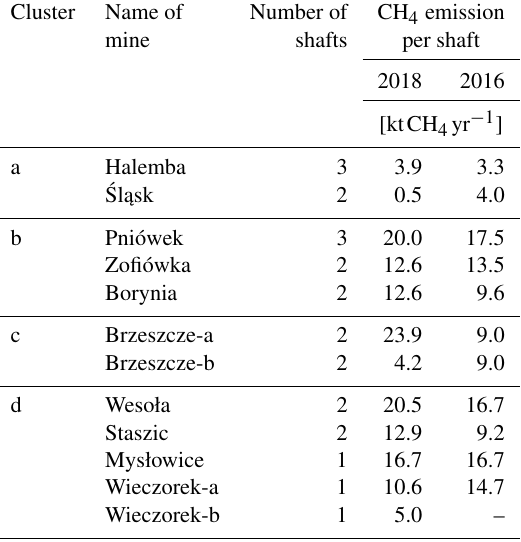
Table 1. Investigated coal mines and their annual CH 4 emissions based on the CoMet ED v4 inventory for the year 2018. The values for 2016 are only listed for comparison. The locations of clusters are shown in Fig. 2 and the position of the individual ventilation shafts are marked in the Results section in Figs. 5, C2, C4, and